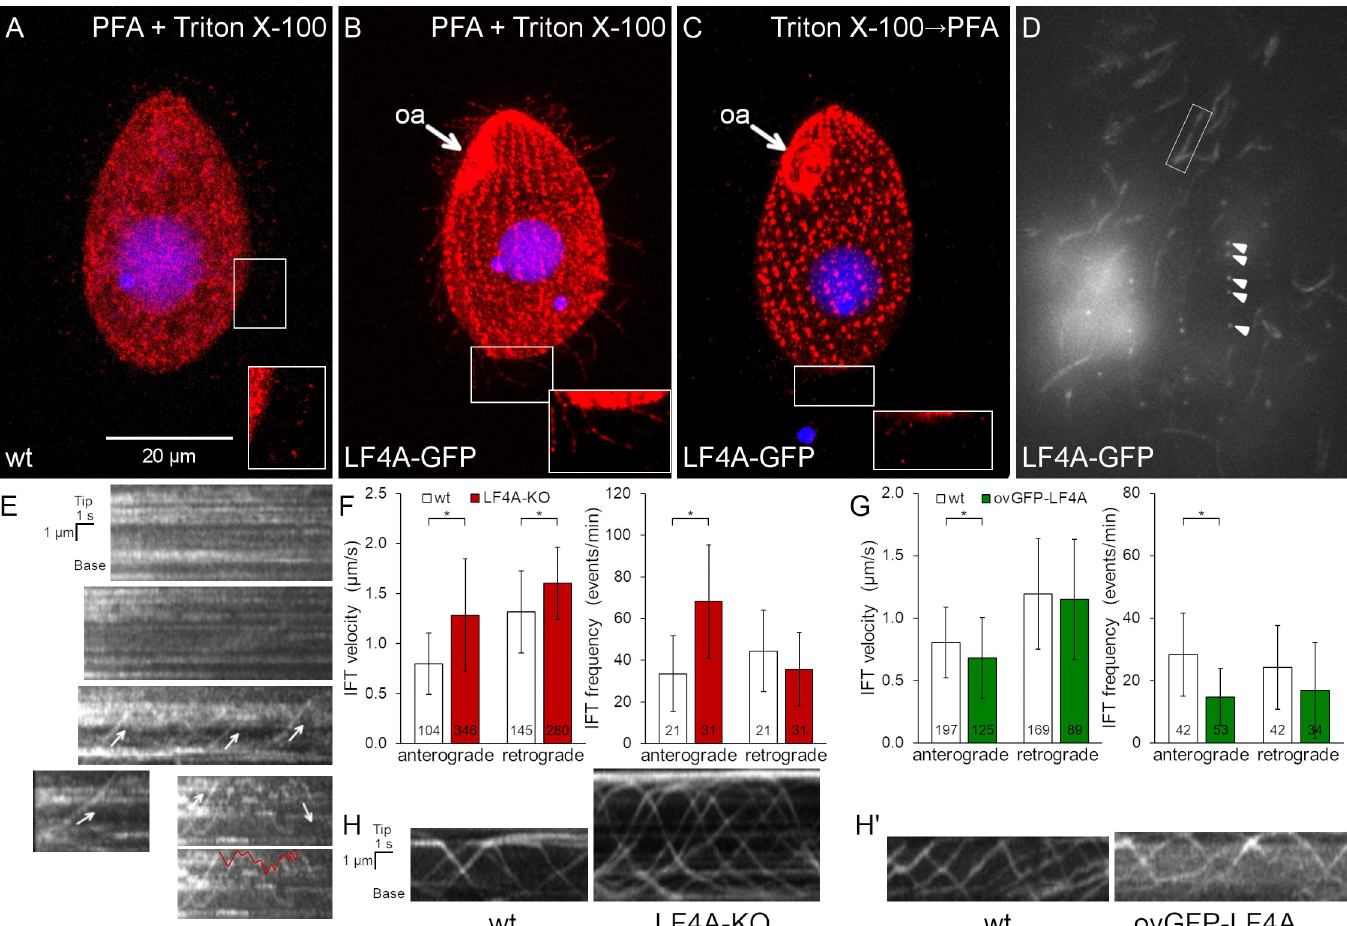
Fig 2. LF4A-GFP localizes to the basal bodies and along cilia, is transported by IFT and affects IFT. (A-B) A wild-type (negative control non-GFP expressing) cell (A) and a cell expressing LF4A-GFP under the native promoter (B) were subjected to simultaneous fixation/permeabilization (using a mixture of paraformaldehyde and Triton X-100) and stained with the anti-GFP antibodies (red) and DAPI (blue). In the negative control, the red background (anti-GFP) signal is in the cell body and occasionally at the tips of cilia (A inset). Specific LF4A-GFP signal is present near the basal bodies and along the shafts of locomotory cilia (B inset compare to A inset). (C) An LF4A-GFP expressing cell that was first permeabilized (with Triton X-100) and then fixed (with paraformaldehyde) prior to immunofluorescence. Compared to (B), the LF4A-GFP signal remained strong near the basal bodies but is decreased in cilia. (D) A TIRFM image of a live LF4A-GFP-expressing cell. Arrowheads indicate several basal bodies within a locomotory row, the box highlights an example of a ciliary shaft. (E) Five representative examples of kymographs obtained from the TIRFM videos of LF4A-GFP cells. In most cilia, LF4A-GFP particles are stationary and some move with velocities similar to IFT velocities (arrows) or diffuse (an example of a diffusion event is marked with a red line on the duplicate of the bottom right kymograph). (F) The IFT velocities (left) and IFT event frequencies (right) in cilia of either wild-type or LF4A-KO cells that express DYF1-GFP, an IFT reporter. (G) The IFT velocities (left) and event frequencies (right) in cilia of either wild-type or GFP-LF4A- overexpressing cells. Both strains were exposed to Cd 2+ for 3 hours. In (F) and (G), the sample sizes are indicated, asterisks mark significant differences (one way Anova p < 0.01), error bars represent SDs. (H) Examples of kymographs of GFP-DYF1 in cilia of either wild-type or LF4A-KO cells corresponding to the data shown in panel F. (H ' ) Examples of kymographs of GFP-DYF1 in either wild-type or GFP-LF4A overproducing cells corresponding to the data shown in panel G. Abbreviations: oa, oral apparatus; PFA,